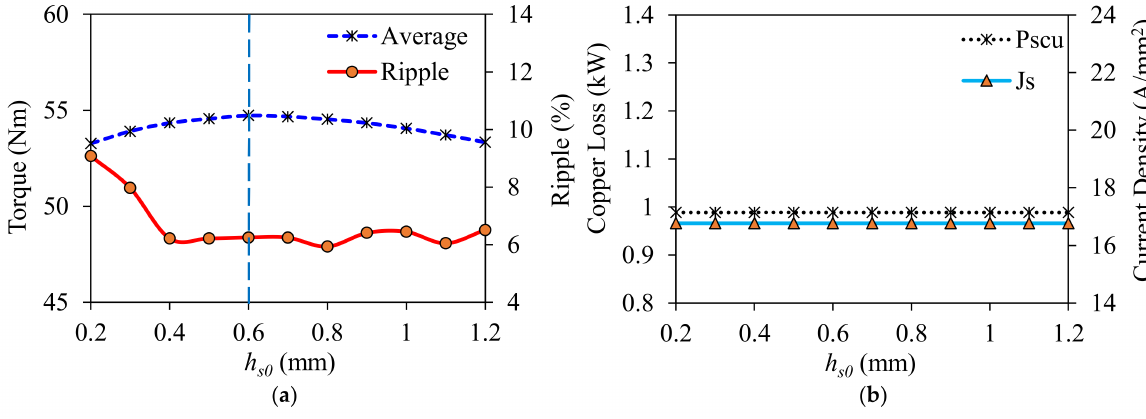
Figure 39. Variation of some key performance characteristics with h s 0 : ( a ) torque and torque ripple and ( b ) stator copper loss and current